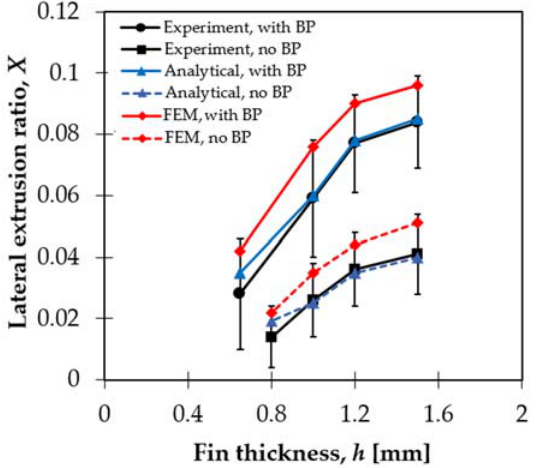
Figure 2. The dependence of the lateral extrusion ratio on the gap ‐ width, for a back ‐ pressure (BP) of 110 MPa, as well as without back ‐ pressure. FEM—finite element modeling.